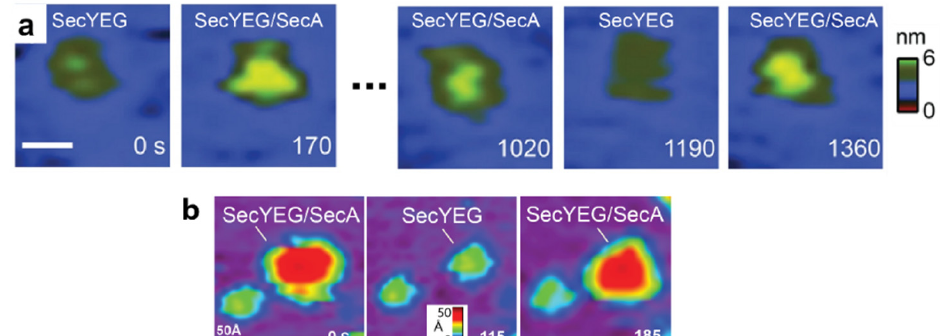
Figure 5. Direct visualization of the association and dissociation of translocase complexes SecYEG/SecA on two distinct supporting surfaces. ( a ) Image sequence on glass: at t = 0 s the cytoplasmic SecYEG protrusion is observed in the membrane. Indeed, 170s later, SecA binds, as indicated by the significant increase in protrusion height and volume. SecA dissociates at 1190 s. At 1360 s, SecA has associated with SecYEG. The scale bar is 100 Å. ( b ) Image sequence on mica: at 115 s, SecA dissociates from the membrane to reveal SecYEG beneath, and then SecA is seen to associate. Note that SecYEG in the bottom left remains unoccupied for all images, acting as a reference. The scale bar is 50 Å. Data are adapted from Refs. [15, 43].